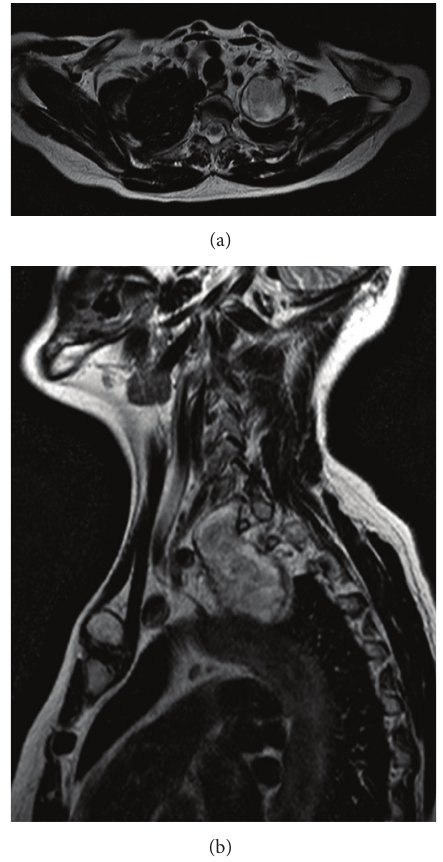
Figure 3: ((a) and (b)) Axial and sagittal view. MRI of brachial plexus showing a well-circumscribed encapsulated tumor arising from the left brachial